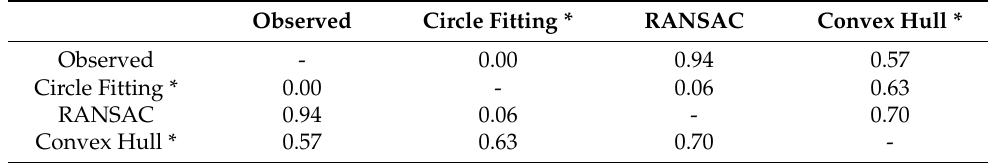
Table 4. Asymptotic significance based on post-hoc analysis (Wilcoxon test).